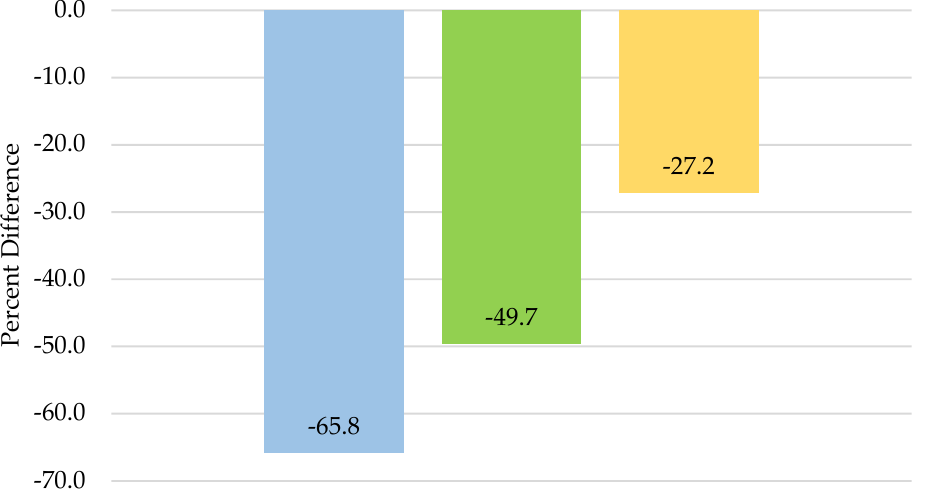
Figure 1. Percent difference of 2019 adjusted annual positive prescription medication expenditures for United States older adults (age ≥ 50 years) with pain in the past four weeks relative to individuals who reported having fair/poor health for those with excellent health (blue bar), very good health (green bar), and good health (yellow bar). The negative bars indicate those with excellent, very good, or good health have lower costs relative to those with fair/poor health.